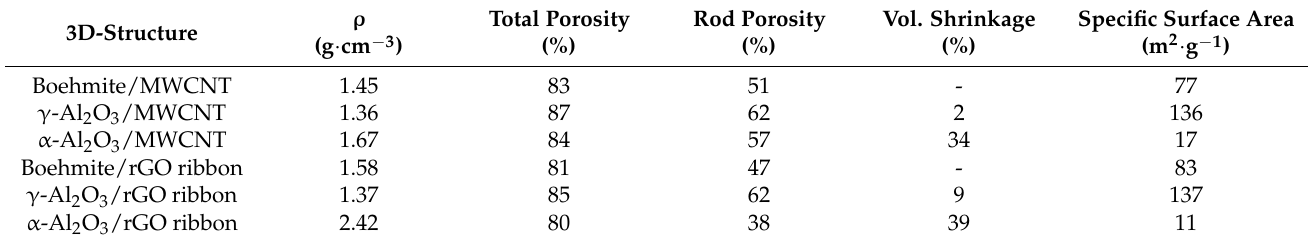
Table 2. Density ( ρ ), porosity, and shrinkage of the composite